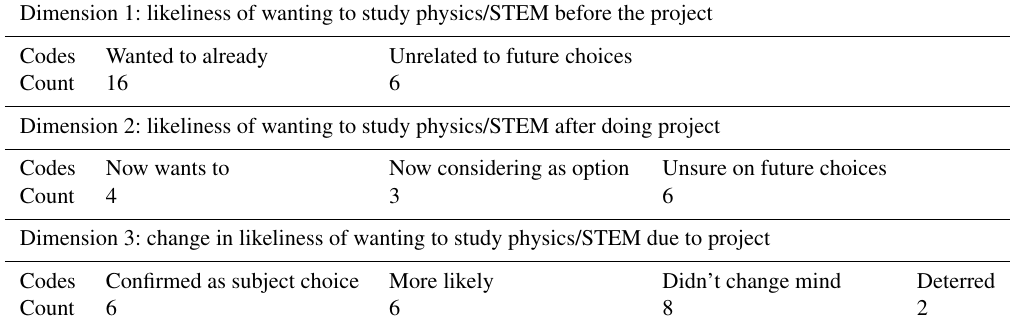
Table 4. Qualitative coding of students’ responses concerning their future aspirations along with counts ( n = 52 of 63). Dimension 1: likeliness of wanting to study physics/STEM before the